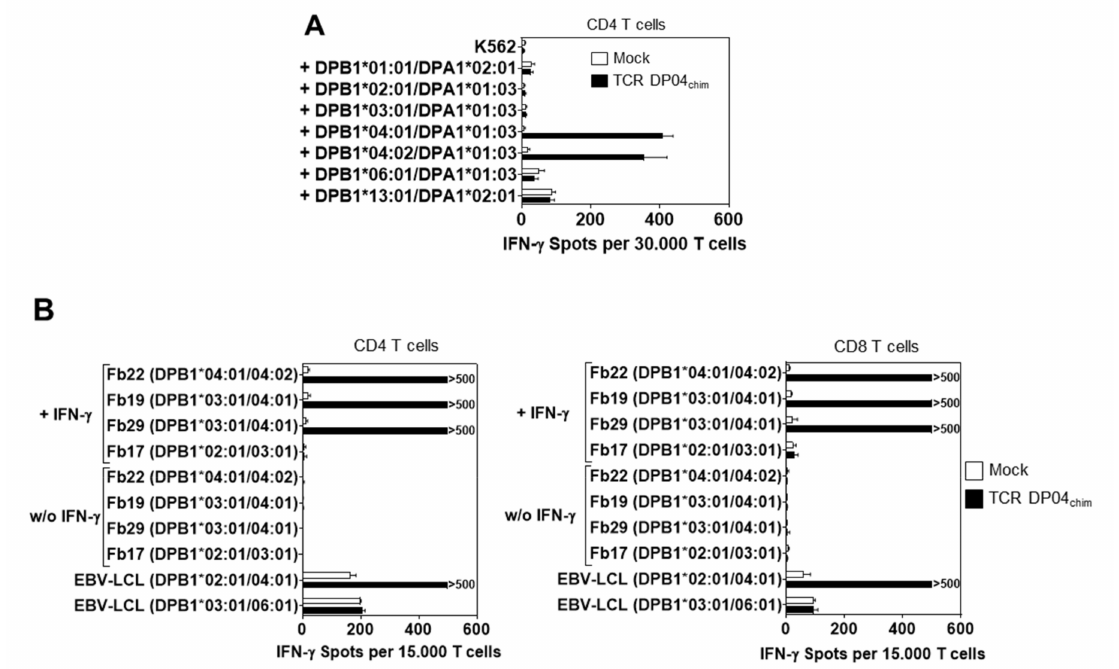
Figure 3. Reactivity of TCR DP04 chim redirected T cells against di ff erent HLA-DP alleles. ( A ) K562 were transfected with RNA encoding for di ff erent HLA-DPB1 chains and their most common associated HLA-DPA1 chains. Pre-stimulated CD4 T cells were transfected with TCR DP04 chim coding RNA (CD4 TCR DP04 chim )orwithoutRNA(CD4Mock)andIFN- γ spotformationwastesteduponincubation with HLA-DP transfected K562 cells at an E: T ratio of 0.6:1. The figure depicts spot numbers from three di ff erent HLA-DPB1*04:01 negative healthy T cell donors and standard deviation of mean is shown. ( B ) Pre-stimulated human CD4 (left panel) and CD8 T cells (right panel) from an